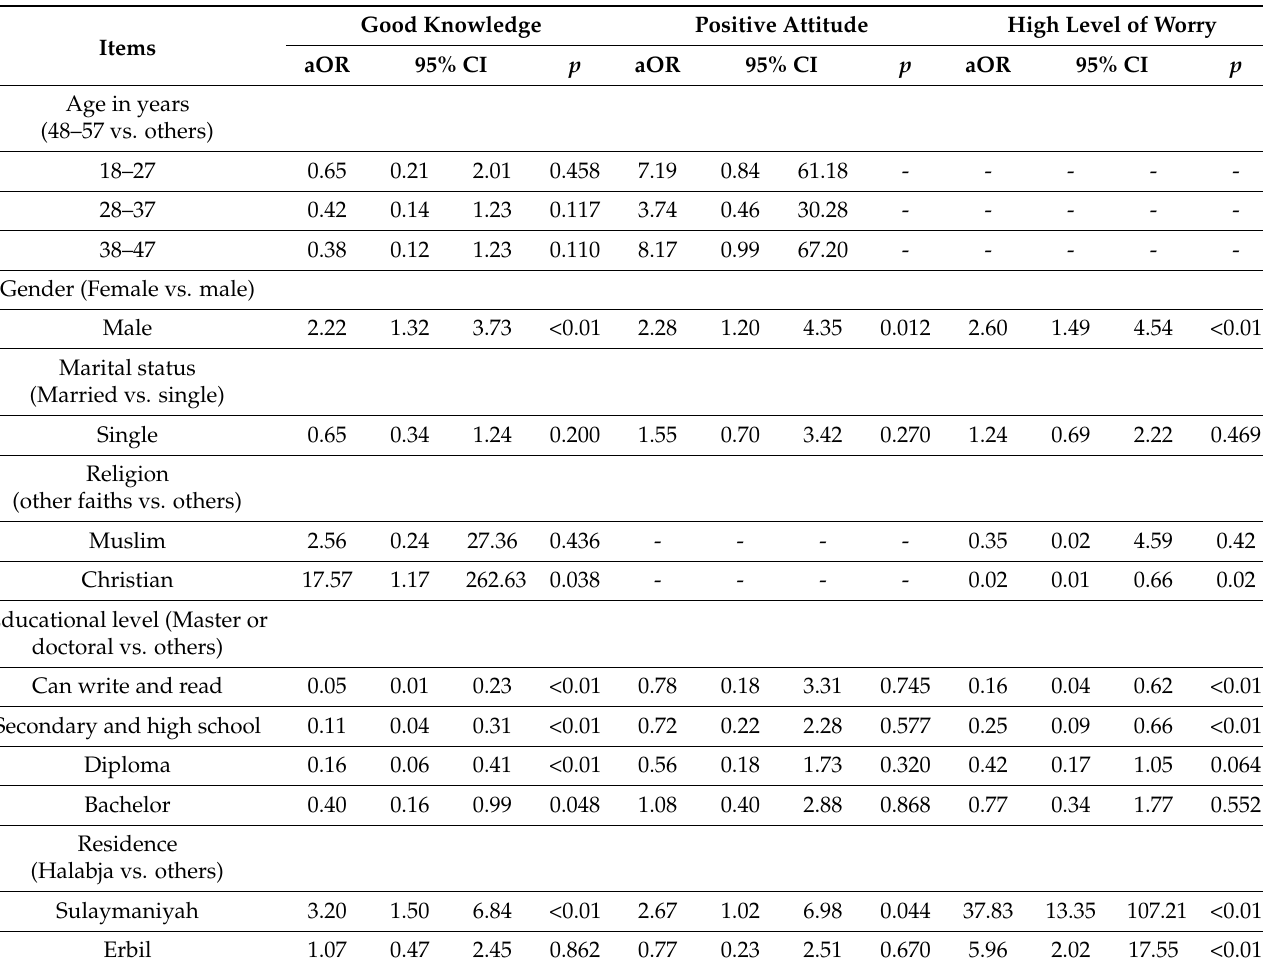
Table 5. Multivariate logistic regression analysis to evaluate the predictive factors associated high knowledge, attitude, and worry scores toward mpox ( n =